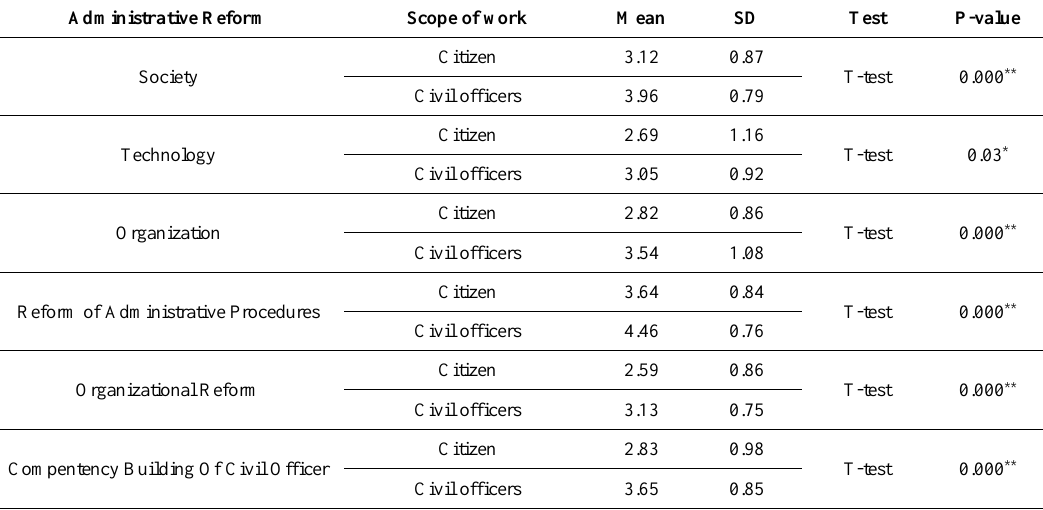
Table 9. Digital transformation and administrative reform under Scope of work variables Administrative Reform